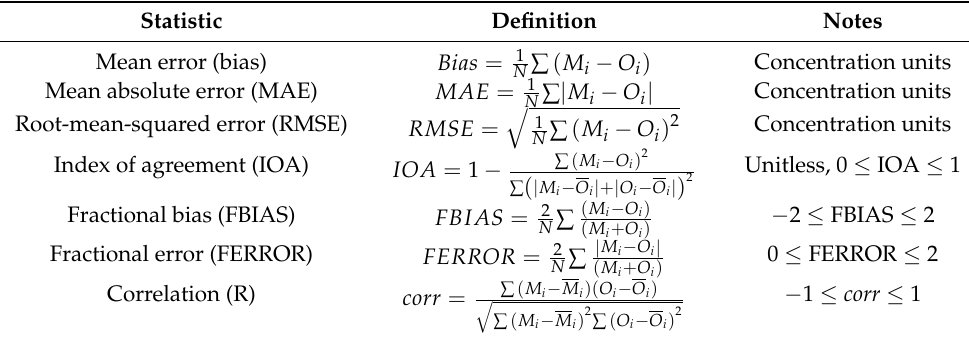
Table 1. Statistical measures of evaluation of forecast